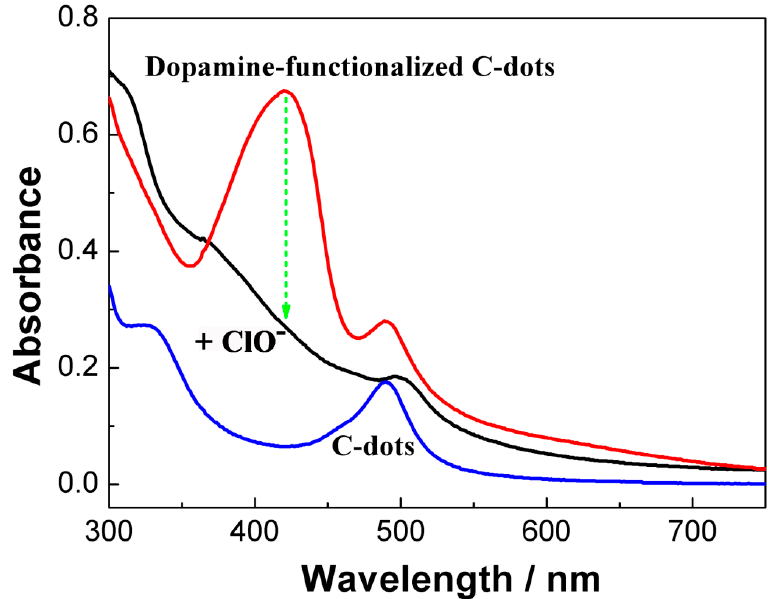
Figure 5. UV-Vis absorption spectra of C-dots, dopamine-functionalized C-dots before and after the addition of ClO − .